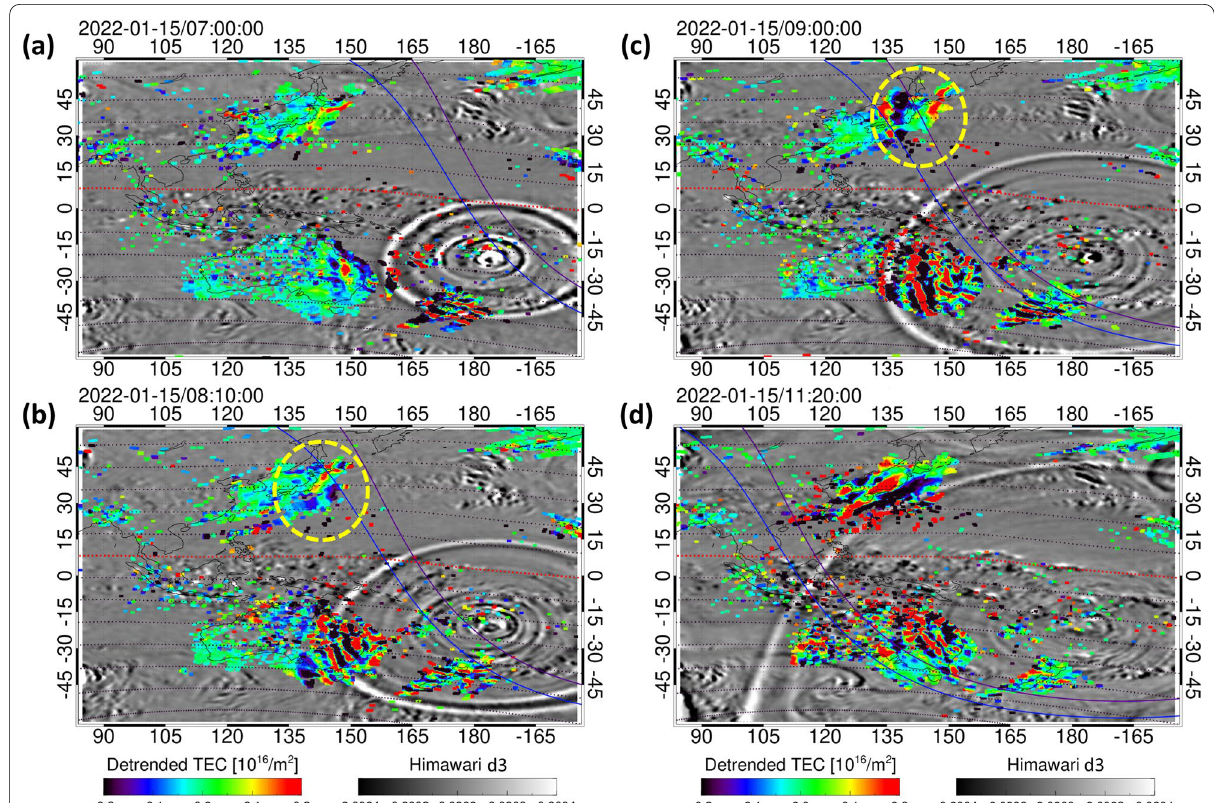
Fig. 1 a – d Two-dimensional maps of detrended TEC and normalized temperature deviation from simple running average of TIR (d3) in geographical coordinates at 07:00, 08:10, 09:00, and 11:20 UT on 15 January. The d3 value is indicated by the grey scale in a range from 0.0004. The red horizontal dotted line represents the magnetic equator calculated with the IGRF-13 model. The blue and purple curves indicate the sunset terminators at 105 and 300 km, respectively. The yellow dashed circles in panels ( b ) and ( c ) show that the TEC perturbations appear with a north–south wavefront structure over Japan before the arrival of air pressure disturbances associated with the volcanic